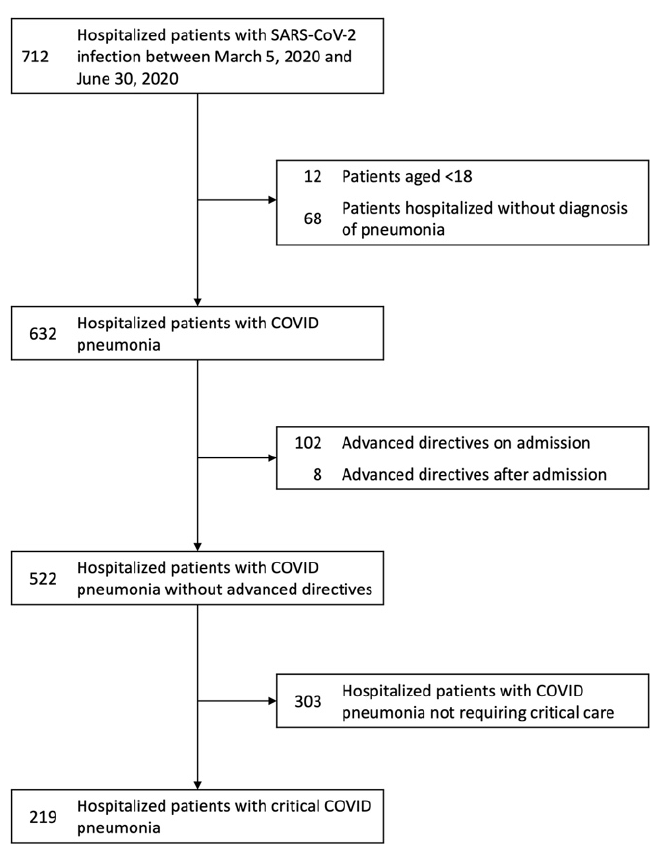
Figure 1. Flowchart of patients with COVID-19 hospitalized in the city of Louisville, KY, from 5 March 2020 to 30 June 2020. The 219 patients with critical COVID-19 were selected upon elimination of 67 patients with do-not-resuscitate and do-not-intubate advanced directive orders. Similarly, the 303 patients with non-critical COVID-19 pneumonia resulted in the elimination of 43 patients. Abbreviations: COVID-19, coronavirus disease 2019; DNI, do-not-intubate; DNR, do-not-resuscitate; SARS-CoV-2, severe acute respiratory syndrome coronavirus-2. Table 1. Characteristics of patients with COVID-19 pneumonia at the time of assignment to the groups of critical and non-critical illness.